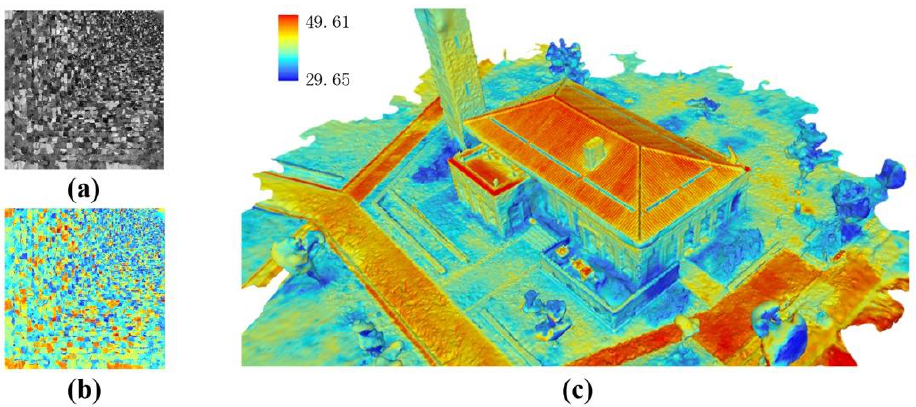
Figure 10. Images of ( a ) the gray map, ( b ) the color map in red-green-blue (R-G-B) and ( c ) the 3D model in R-G-B.